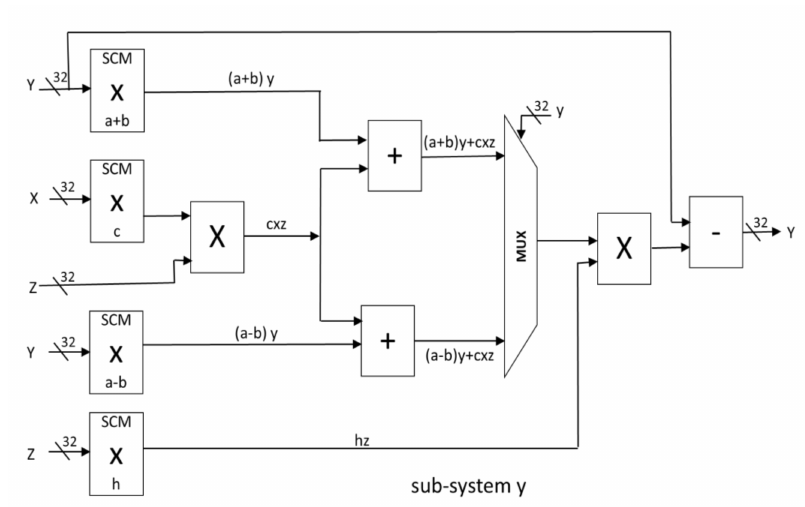
Figure 18. Realization of the sub-system Y on FPGA.